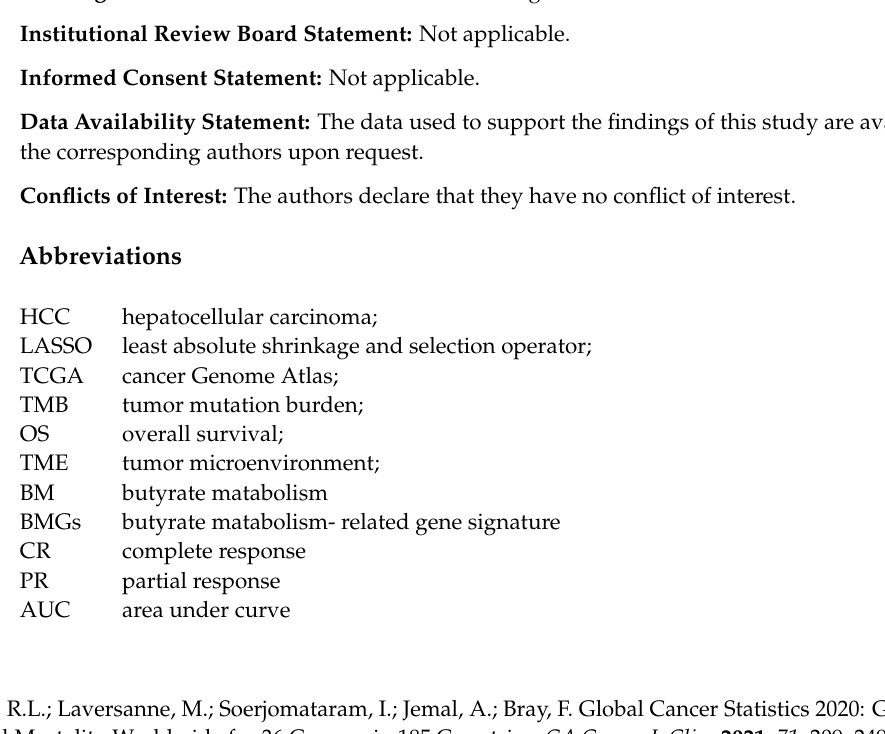
DCA. Figure S4: Comparison of BMGs with other 2 gene signatures with the use of DCA. Figure S5: Drugs interacting with the genes comprising the BMGs. Figure S6: (A) The enriched molecular functions in low-risk group. (B) The enriched molecular functions in high-risk group. Figure S7: The GO and KEGG analysis of DEGs beteween low- and high-risk patients. Figure S8: Stemness indices and somatic mutation